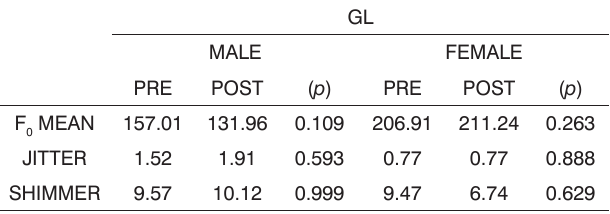
Table 3. Mean fundamental frequency (F [ ε ], and of jitter and shimmer, before and after phonation into a straw exercises, according to the group with lesions (GL) and gender